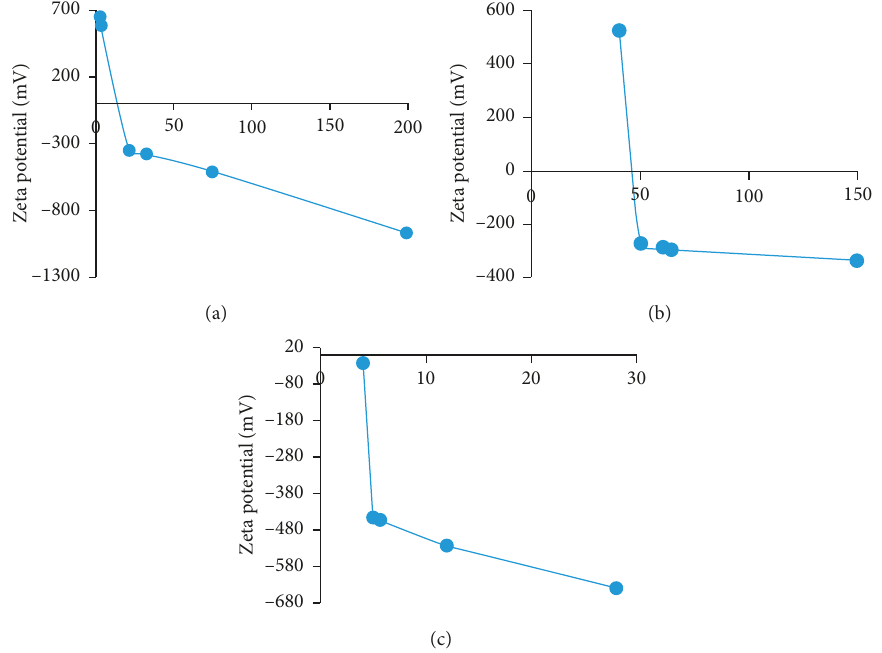
Figure 11: Effect of polymer-polymer ratio on the zeta potential of the final solution (a) CMC/CS, (b) CMS/CS, and (c)